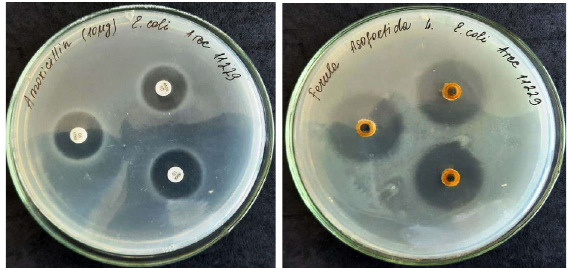
Fig. 6. Results of antimicrobial activity of CO Ferula asafoetida L. and amoxicillin against Escherichia coli ATCC 11229